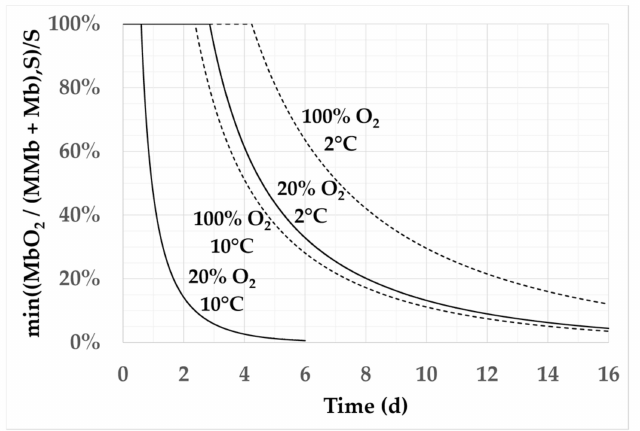
Figure 3. Impact of environment conditions on the model outputs. Impact of the packaging oxygen content and storage temperature on the normalized MbO 2 /(MMb + Mb) results calculated by the reaction–diffusion model with S = 2 and Ea = 32.5 kJ/mol. Solid lines and dashed lines plot 20% and 100% O 2 , respectively.